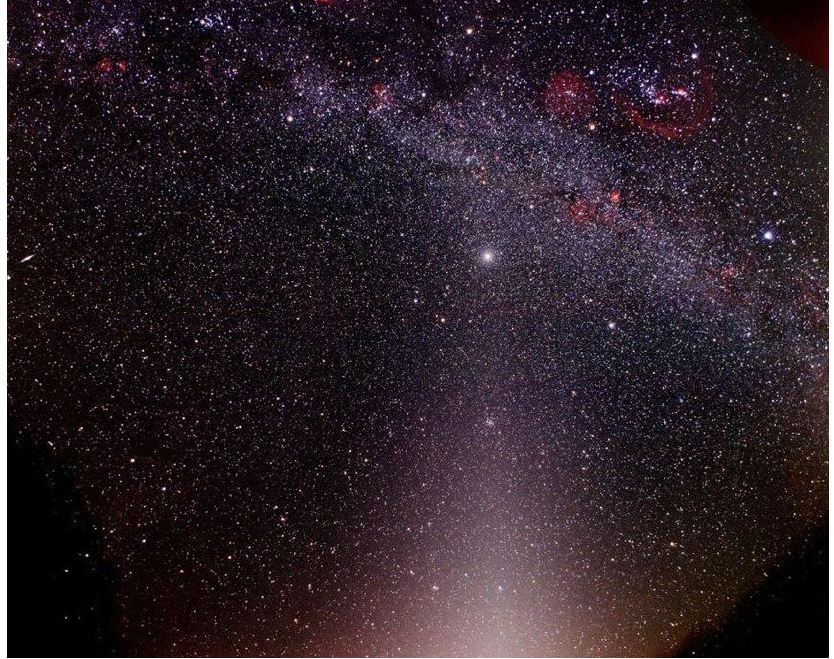
Figure 1. The zodiacal light rises from the horizon, envelops planets along the ecliptic, and intersects the Milky Way, revealing Plato‘s visible god, the celestial X that mirrors the World Soul. (Photo: Matt BenDaniel).